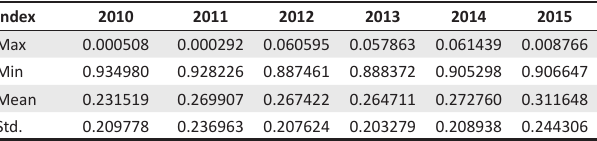
TABLE 4: Descriptive statistics of efficiency of military industrial enterprises in each sample year 2010–2015.